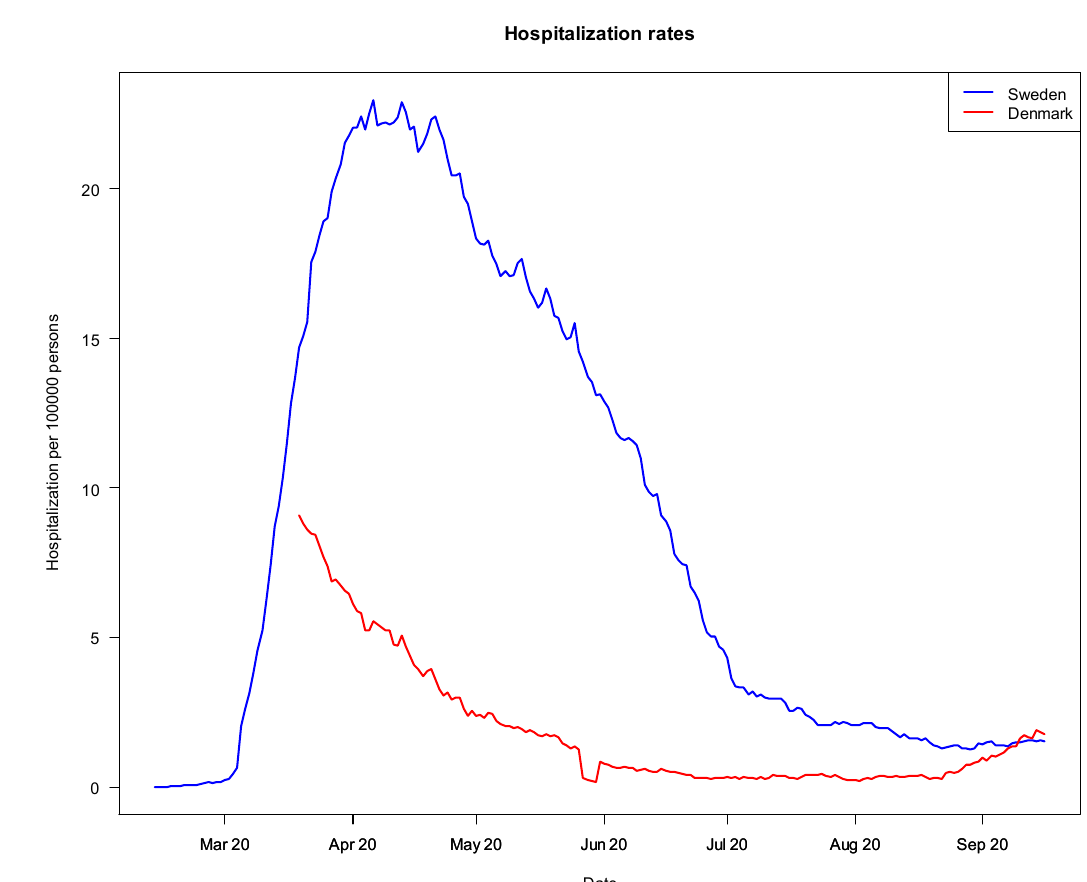
Figure 2. Number of COVID-19 hospitalizations per 100,000 population in Denmark and Sweden, February 2020 to 1 October 2020 (Source: European Centre for Disease Prevention and Control 2021). Notes: Data for per-day measures of hospitalization, used in Figure 2, were only available for Denmark from 2 April 2020. Data prior to this were available per-week, showing an increased hospitalization in Denmark similar to that of Sweden, followed by a decline from around April 2020. We therefore expect a similar increase in hospitalizations in Denmark as in Sweden until 2 April 2020, even though we did not have access to the per-day data.